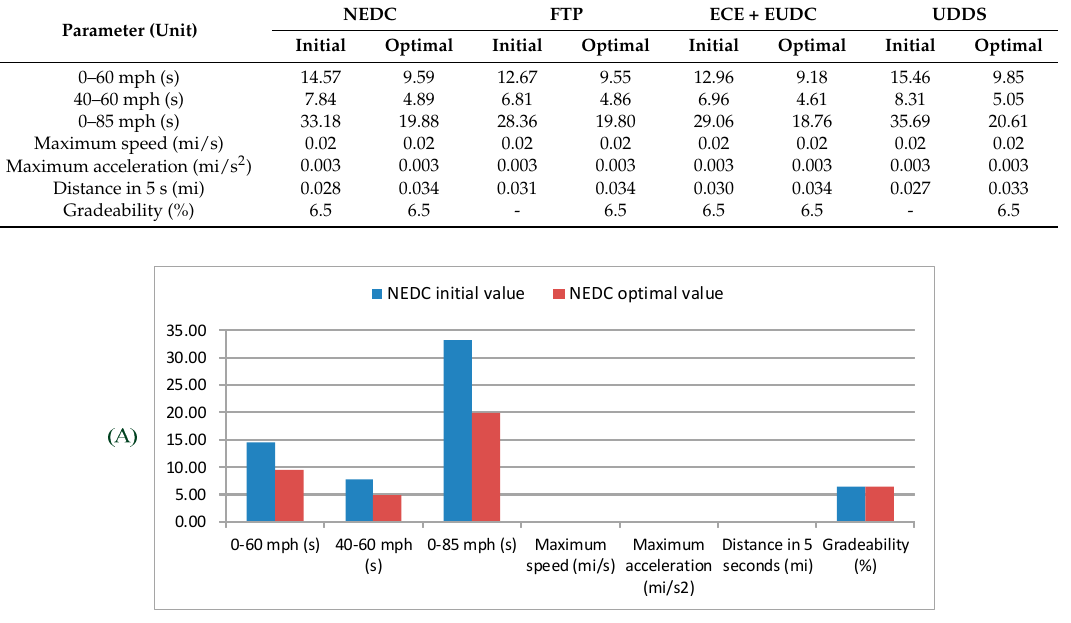
Figure 8. The histogram for FC and emissions using initial and optimal values of the parameters of control strategy. ( A ) FC and emissions based on NEDC cycle; ( B ) FC and emissions based on FTP cycle; ( C ) and emissions based on ECE + EUDC cycle, and ( D ) FC and emissions based on UDDS cycle. Table 9. The result for the dynamic performance using initial and optimal values of the parameters of the control strategy.